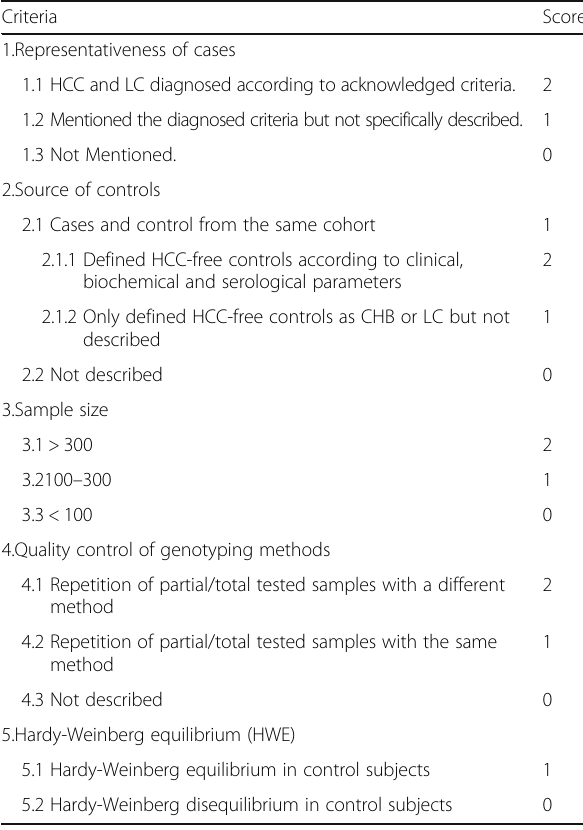
Table 1 Scale for methodological quality